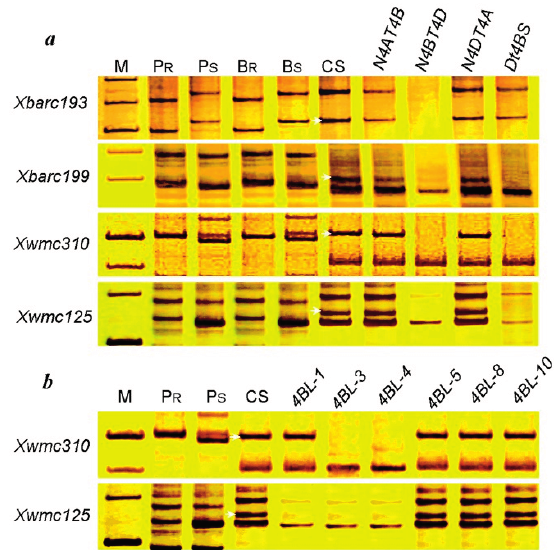
Figure 5. Amplification patterns of linked markers in CH09W89 ( P R ), SY95-71 ( P S ), resistant bulk ( B R ), susceptible bulk ( B S ), Chinese Spring (CS), nullisomic-tetrasomic (NT) 4B, ditelosomic (Dt) 4BS stocks ( a ); and 4BL deletion lines ( b ) of CS; Arrows indicate